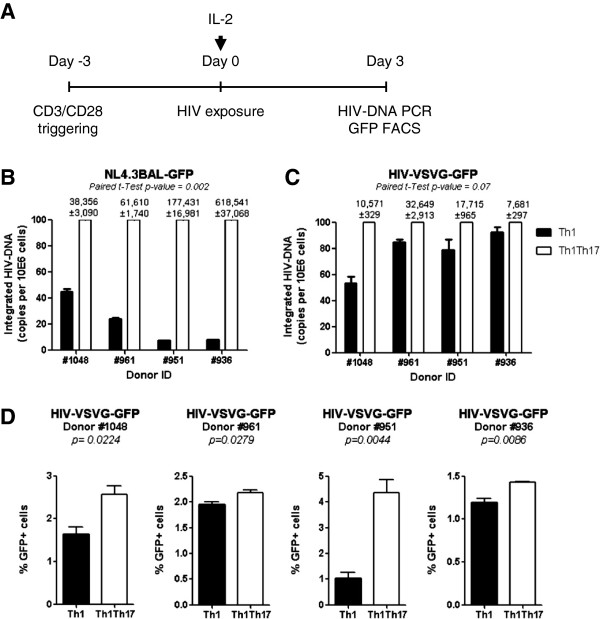
Superior HIV replication in Th1Th17 vs. Th1 cells is regulated at entry and post-entry level. Matched Th1 and Th1Th17 cells were sorted by flow cytometry from four different HIV-uninfected subjects and stimulated via CD3/CD28 for 3 days (A). Cells were exposed to replication competent NL4.3BAL-GFP (B) or single round HIV-VSVG-GFP pseudotyped strains (50 ng HIV-p24/106 cells) (C-D) for 3 h at 37°C. Unbound virus was removed by extensive washing, and cells were cultured for 3 additional days in the presence of IL-2 (5 ng/ml). Integrated HIV-DNA and GFP expression levels were quantified by nested real-time PCR (B-C) and flow cytometry (D), respectively, at day 3 post-infection. Shown in B-C is relative HIV-DNA integration in Th1 vs. Th1Th17 cells (normalized to the maximal value considered to be 100% in Th1Th17 cells); values above graphs are integrated HIV-DNA copies per 106 cells in Th1Th17 cells (mean±SD of triplicate wells). Paired t-Test values are indicated on the graphs.